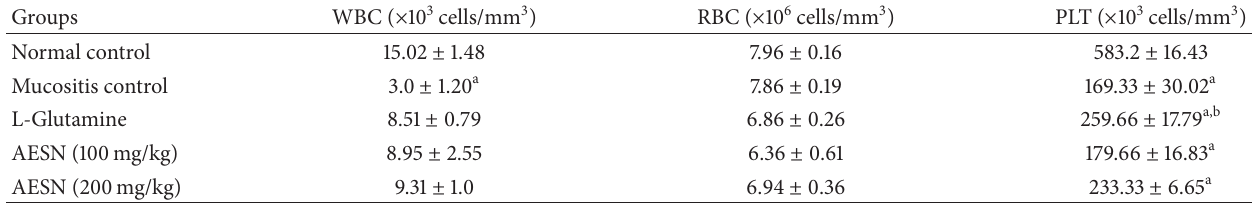
Table 4: Change in hematological parameter on 7th day of study period in methotrexate induced oral mucositis. Groups